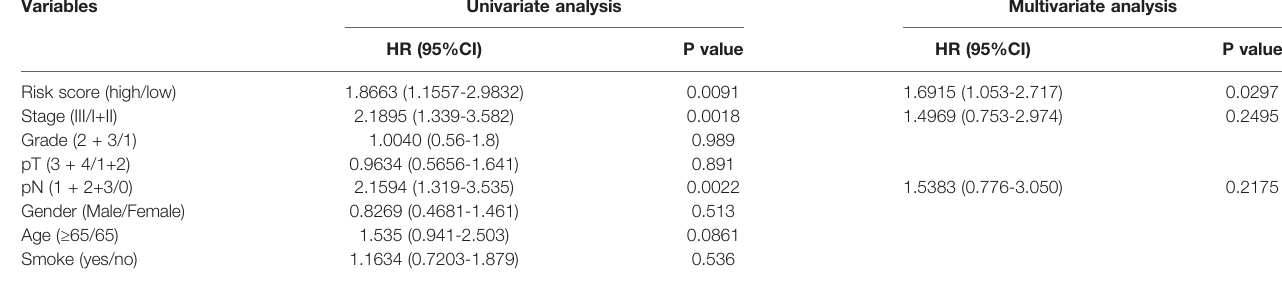
TABLE 2 | Univariate and Multivariate cox regression analysis-GEO cohort.